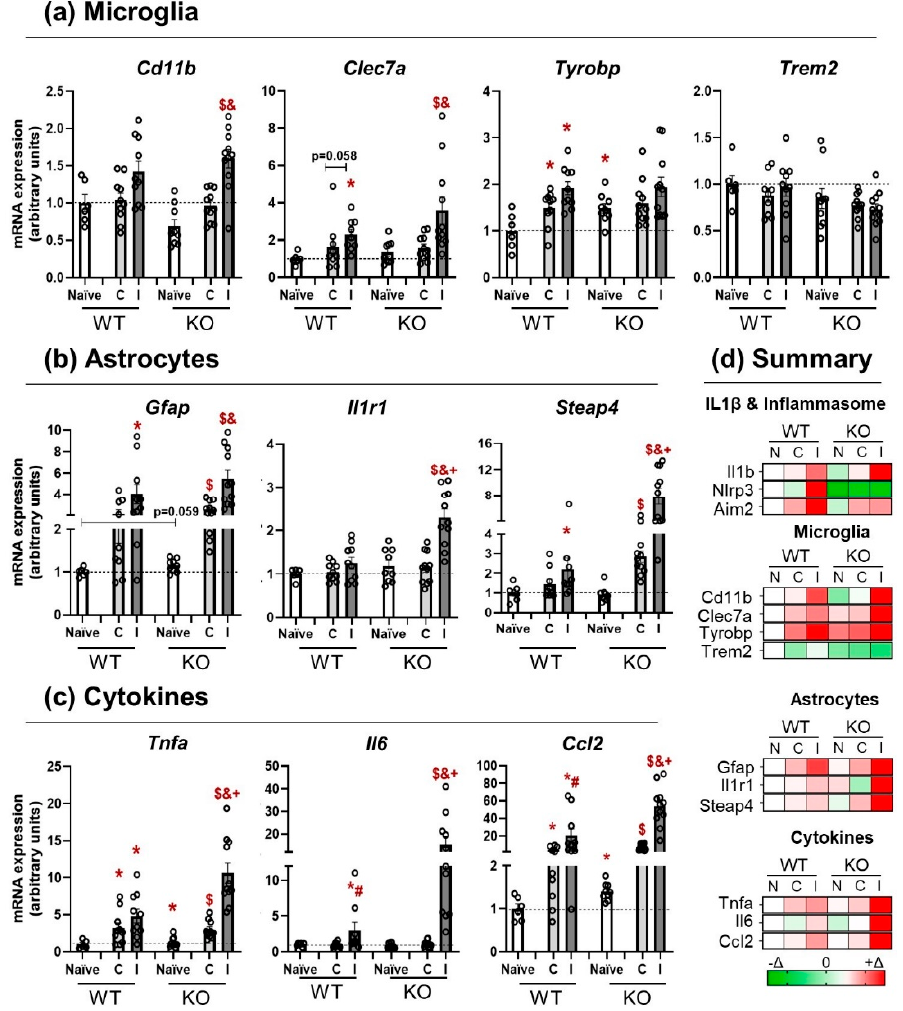
Figure 3. Glial response and cytokine expression in WT and KO mice 24 h after trauma. ( a ) Microglia transcripts panel, showing the changes in the mRNA levels of Cd11b, Clec7a, Tyrobp, and Trem2. Naïve, contralateral, and ipsilateral sides were compared in both strains. ( b ) Response of the astrocytic markers Gfap, Il1r1, and Steap4 in WT and KO. Naïve, contralateral, and ipsilateral sides were compared in both strains. ( c ) mRNA expression of the pro-inflammatory cytokines Tnfa, Il6, and Ccl2 in WT and KO animals. Naïve, contralateral, and ipsilateral sides were compared in both strains. ( d ) Graphical summary of the changes observed at mRNA level for all the studied transcripts. Green colors represent a decrease, white means no change, and red palette corresponds to increases in the mRNA expression. Mean ± SEM ( n = 6–11). Kruskal–Wallis followed by Mann–Whitney tests p ≤ 0.05. (* vs. WT Naïve; # vs. WT Contra; $ vs. KO Naïve; &: KO Ipsi vs. KO contra; + KO Ipsi vs. WT Ipsi (WT: wild type; KO: NLRP3 knockout; C: contralateral; I: ipsilateral).